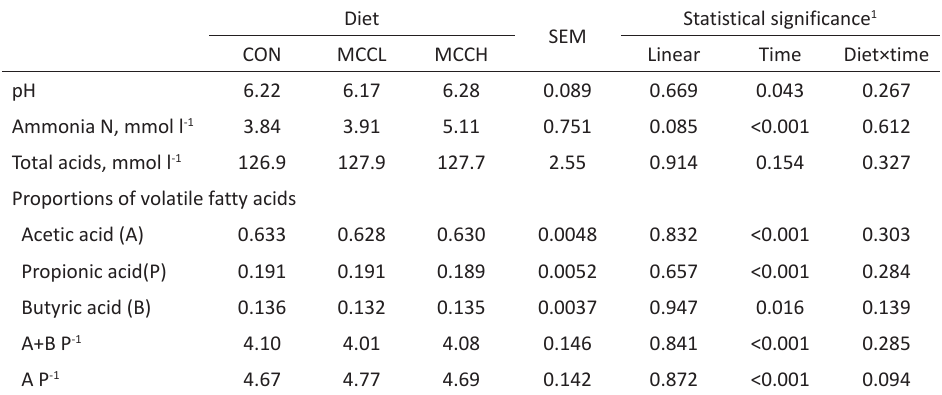
Table 5. Rumen fermentation of dairy cows fed microcrystalline cellulose (MCC)